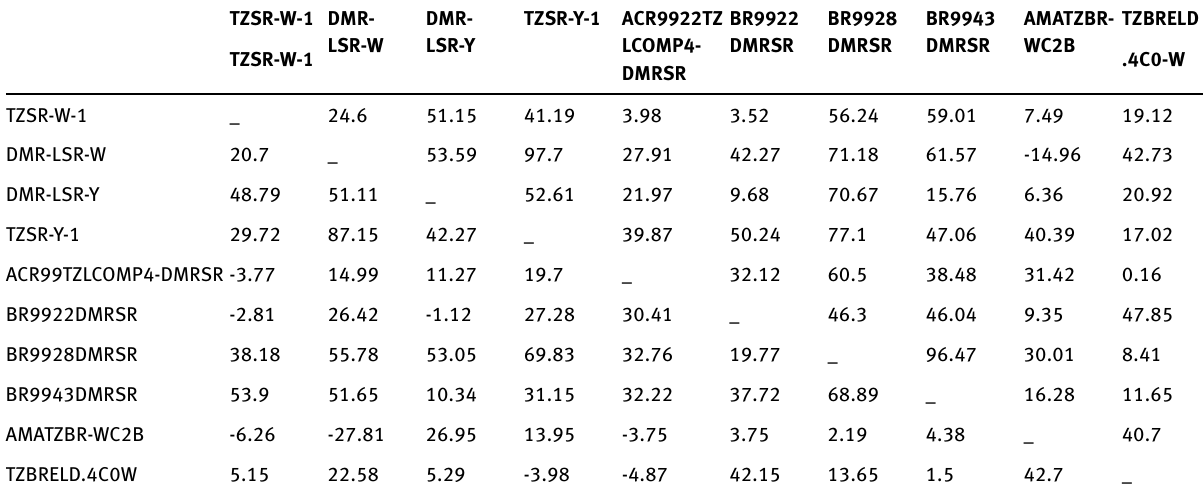
Table 4: Mid-parent heterosis (upper diagonal) and high-parent heterosis (lower diagonal) for maize grain yield in high-N environment at Mokwa and Zaria, 2012